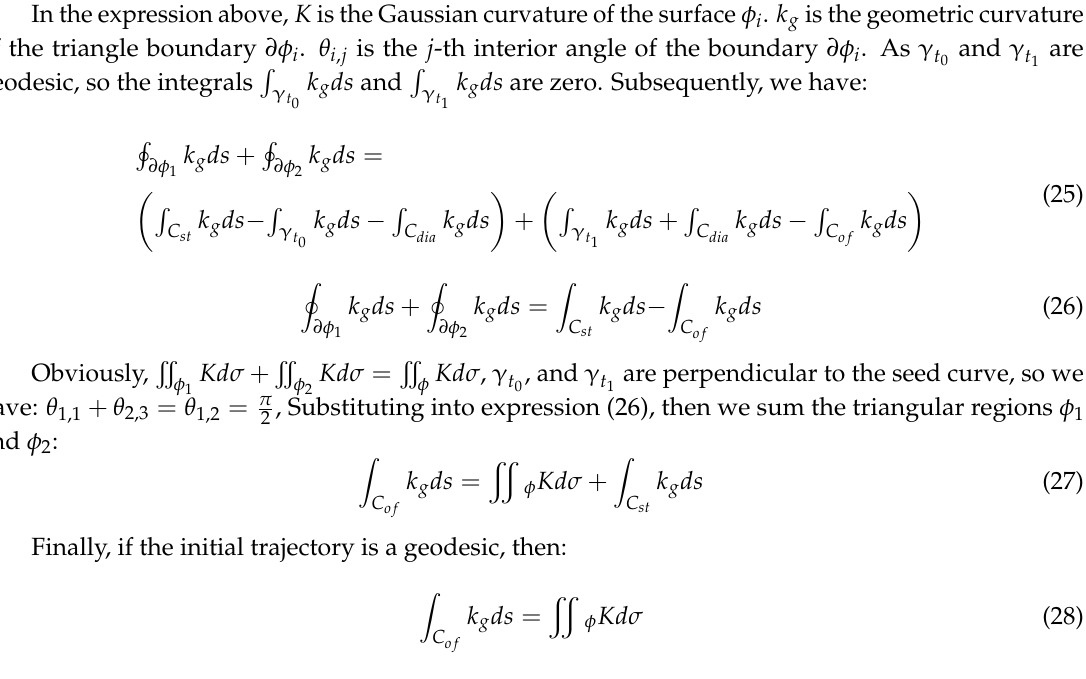
Curvature of Curvature of Surfaces.